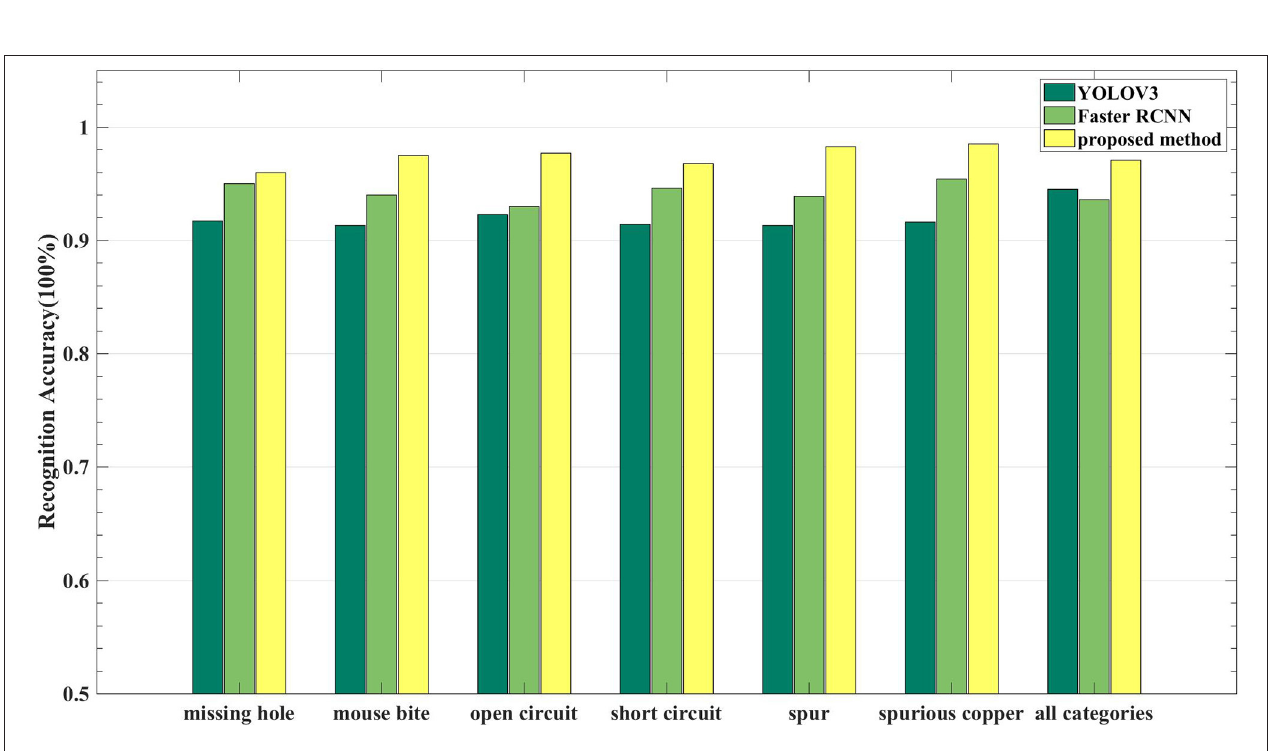
FIGURE 8 | The average precision comparison results of different methods.